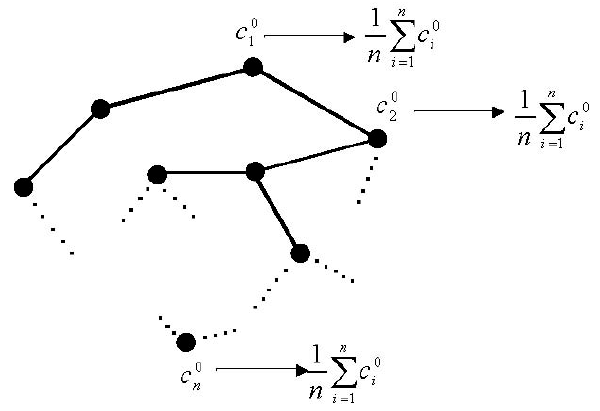
Figure 4. Principle of distributed averaging.